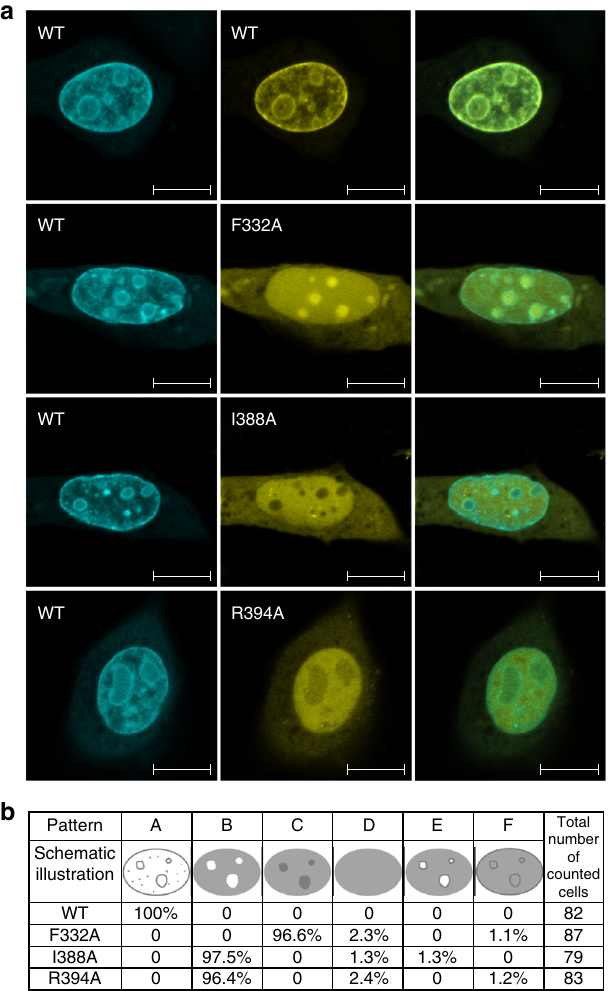
Fig. 7 Subnuclear localization of 3TD and 3TD mutants. Pairs of 3TD proteins were co-expressed as fusion constructs with mCerulean (shown in cyan) or mVenus (shown in yellow) in mouse NIH3T3 cells. An overlay of both signals is shown in the third column. a Exemplary images of wildtype/ wildtype controls (top row) showing a perfect overlay of the two fl uorescence signals. In contrast, images of mutant/wildtype combinations clearly show differences in the sub-nuclear localization of the mutants. Scale bar: 10 µ m. Additional images are shown in Supplementary Figs. 10 and 11. b Summary of the localization data. Around 80 cells were inspected per experiment, classi fi ed to different phenotypes and counted. The following phenotypes were used: A (wildtype like)-granular, perinucleolar with nucleolar exclusion, B-diffused with nucleolar exclusion, C-diffused with nucleolar enrichment, D-diffused, E-diffused, perinucleolar with nucleolar exclusion, F-diffused, perinucleolar with nucleolar